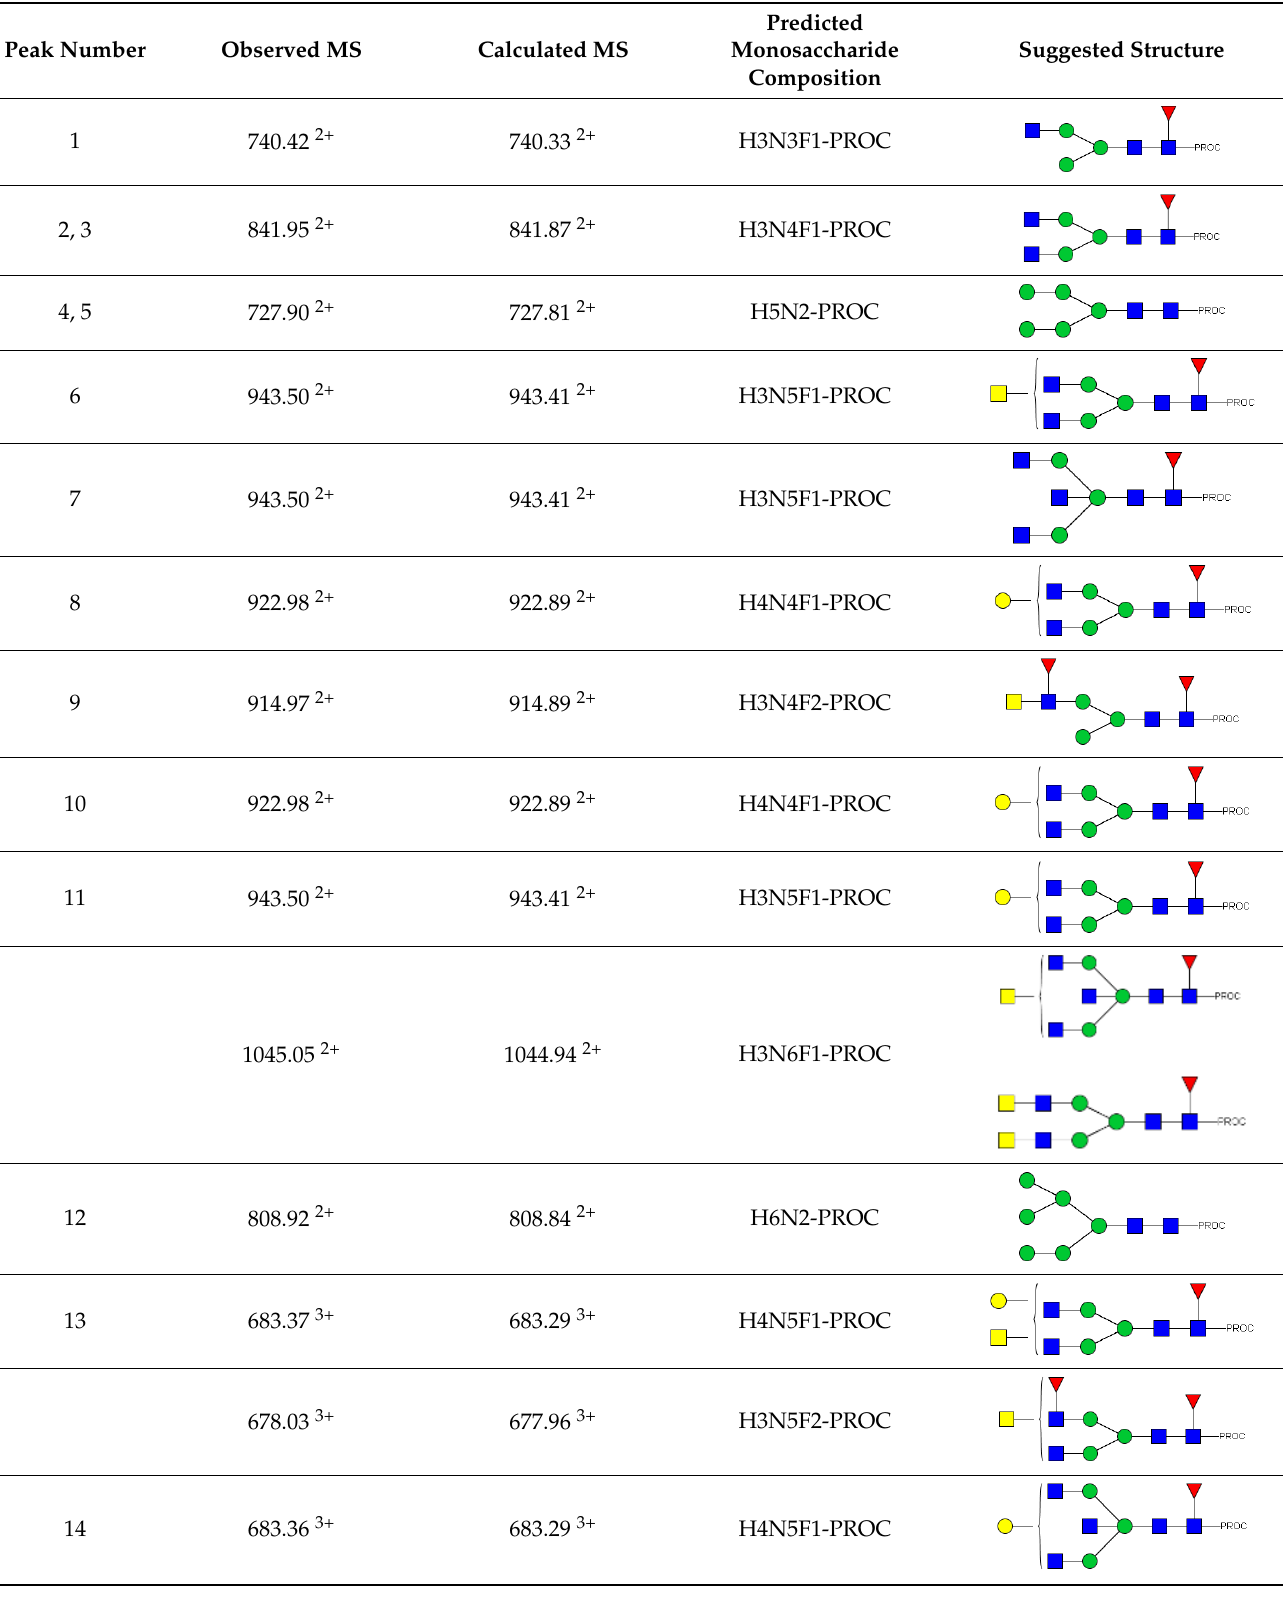
Table 1. Predicted Monosaccharide Compositions and Suggested Glycan Structures for Con-IgE based on observed MS m/z masses. Numbered peaks are shown in Figure 3. H = Hexose; N = N-Acetylhexosamine; F = Fucose; S = Sialic Acid.